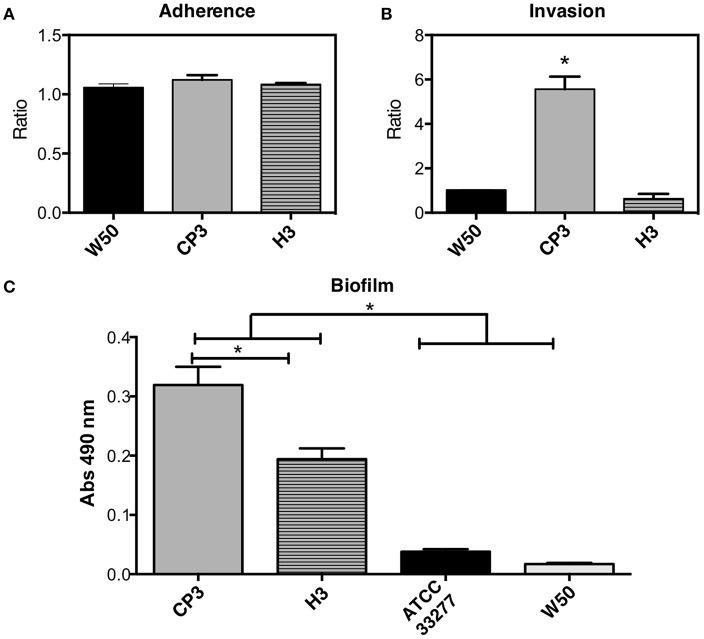
Cellular adherence (A), invasion (B), and biofilm formation (C) of different strains of Porphyromonas gingivalis exhibiting different fimA genotypes. Adherence (A) or invasion (B) were calculated as: the number of viable CFU in infected cells/the number of CFU of initial bacteria inoculum. Biofilm formation (C) was determined by safranin staining. The dye retained in the biofilm was eluted and measured at 490 nm. Invasion, adherence and biofilm assays were performed in triplicate on at least three independent occasions. Values that differ significantly from controls are indicated (SEM; n = 3; *p ≤ 0.05).